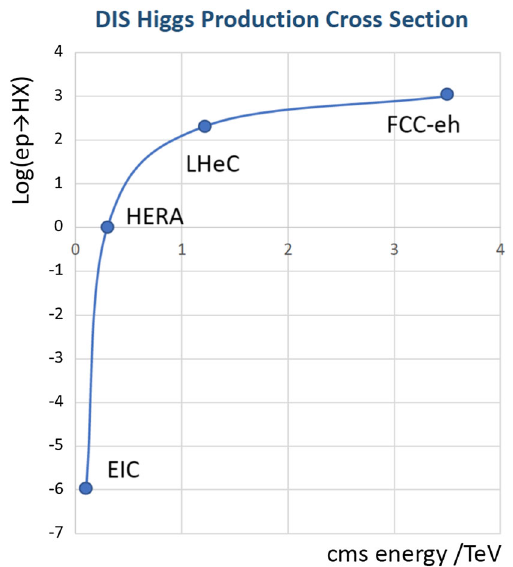
Fig. 2 Inclusive Higgs cross section in charged current e − p DIS, plotted as log (σ/ f b ) , as a function of the cms ep scattering energy, √ (cid:2) s = 2 E e E p in TeV